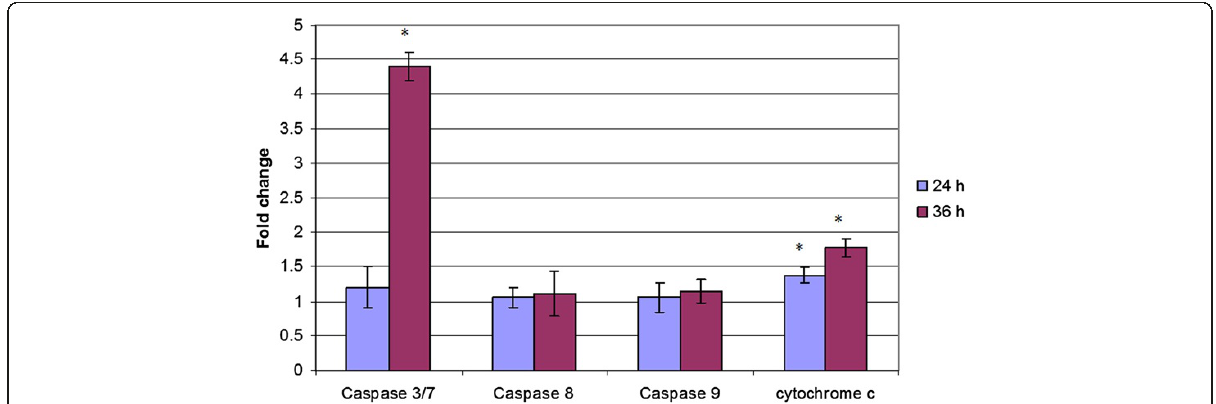
Figure 2 Pandanus amaryllifolius extract induced translocation of cytochrome c into the cytosol, activation of initiator caspase 8, 9 and effector caspase 3/7 (fold change) in treated MDA-MB-231 cells as compared to control cells. Values are presented as means (n=3)±S.E. *signified